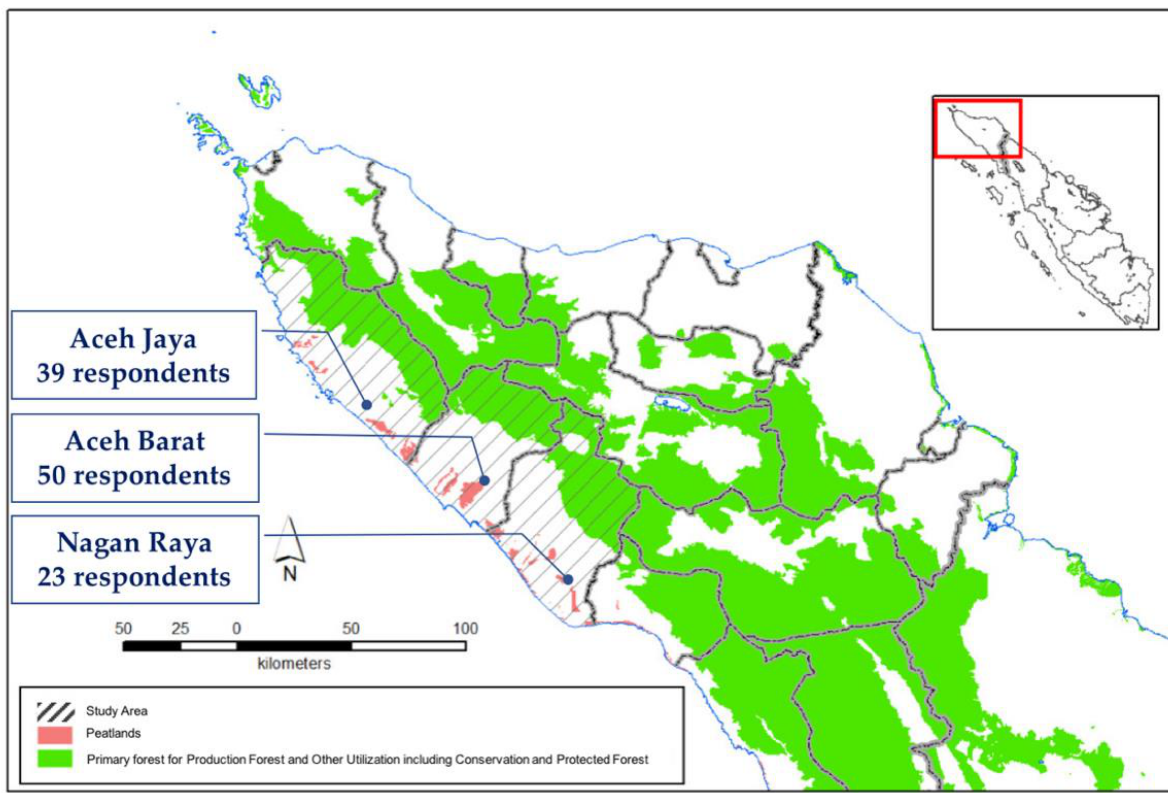
Figure 1. Map showing the location and extent of the study area, which covers three districts in Aceh Province,